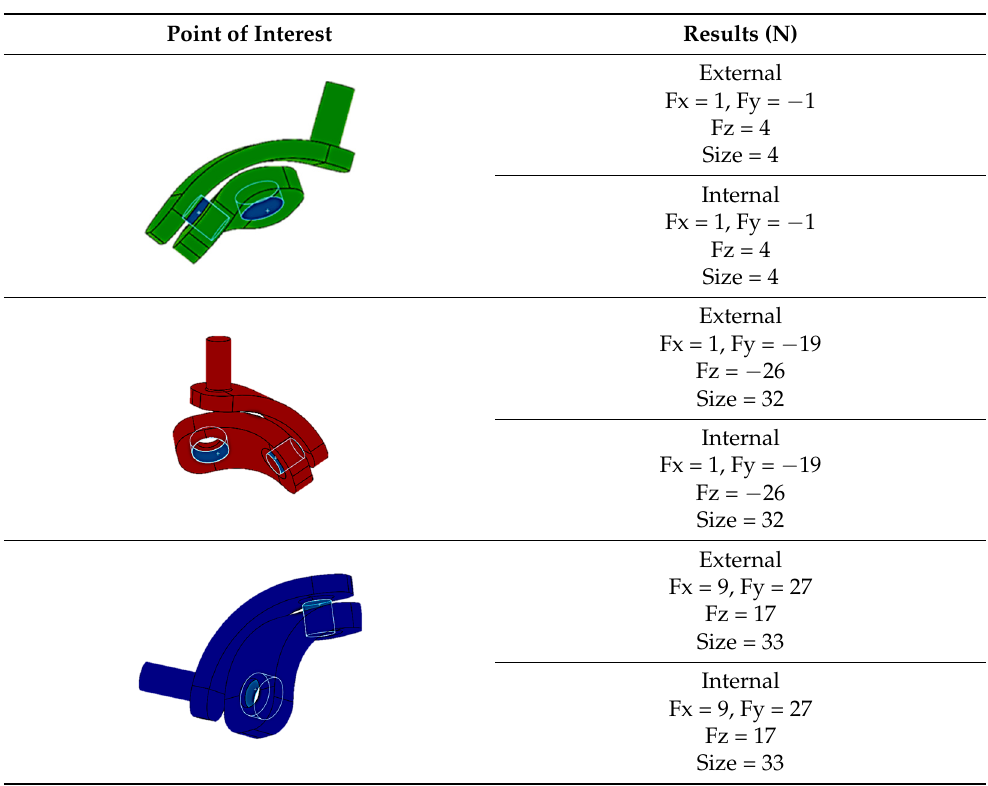
Figure 12. Spheric manipulator. ( a ) Links marked with colors. ( b ) Points of interest for each pair of links. Table 7. Reaction forces of the ball gripping mechanism.